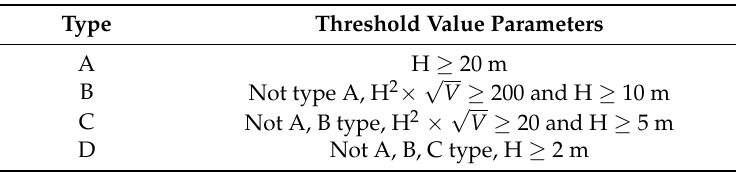
Table 14. Classification of dams in French regulation.